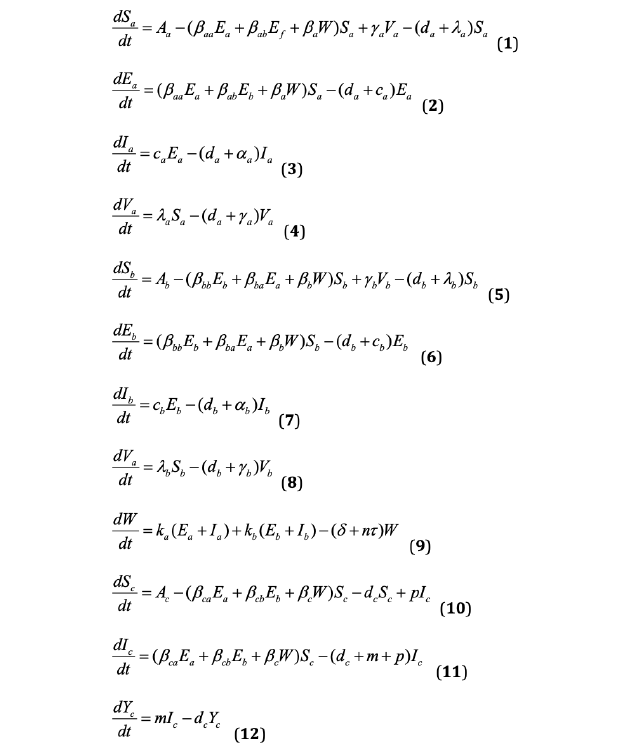
Figure 1. Diagram of the transmission of Brucellosis. S a : susceptible ewe; V a : immunized ewe; E a : recessive infected ewe; I a : isolated infected ewe; S b : sheep with hepatitis B; V b : immunized sheep; E b : recessive infected sheep; I b : isolated infected sheep; W: environmental Brucella; S c : susceptible human population; I c : acutely infected human population; Y c : chronically infected human